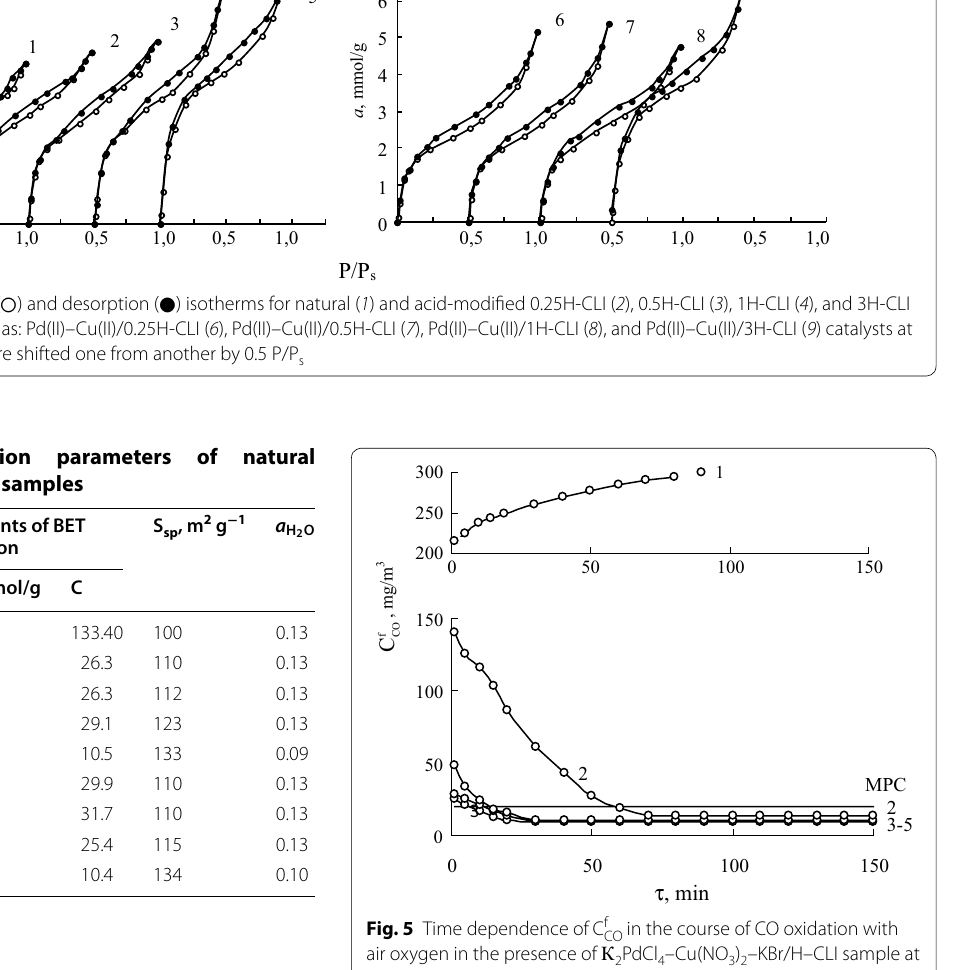
Table 5 PH values for suspensions of natural and acid- modified clinoptilolite samples Sample